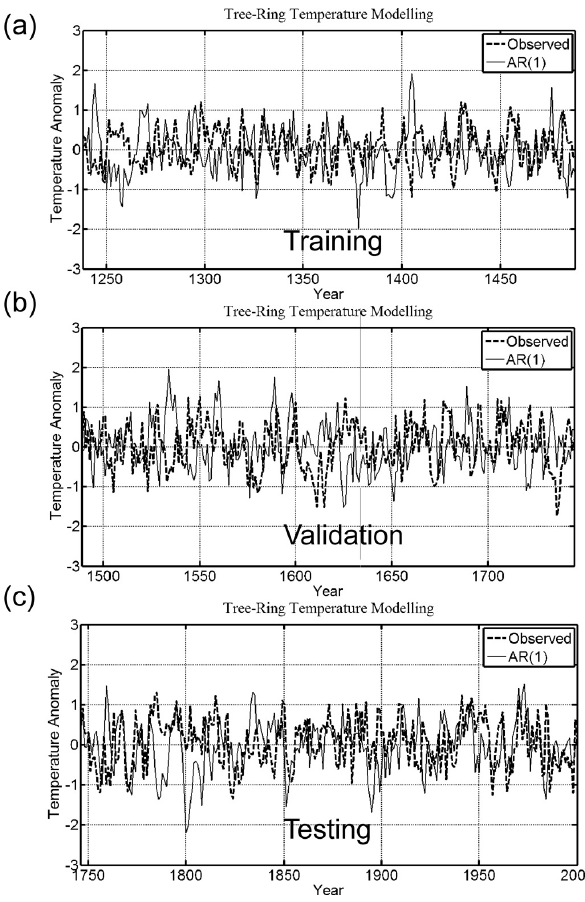
Fig. 11. Tree-ring temperature anomaly reconstruction using Autoregressive method (1) in the period (a) AD1232–1488, (b) AD1489–1745, (c) AD1746–2000. Comparison and correlation analysis between the ac-